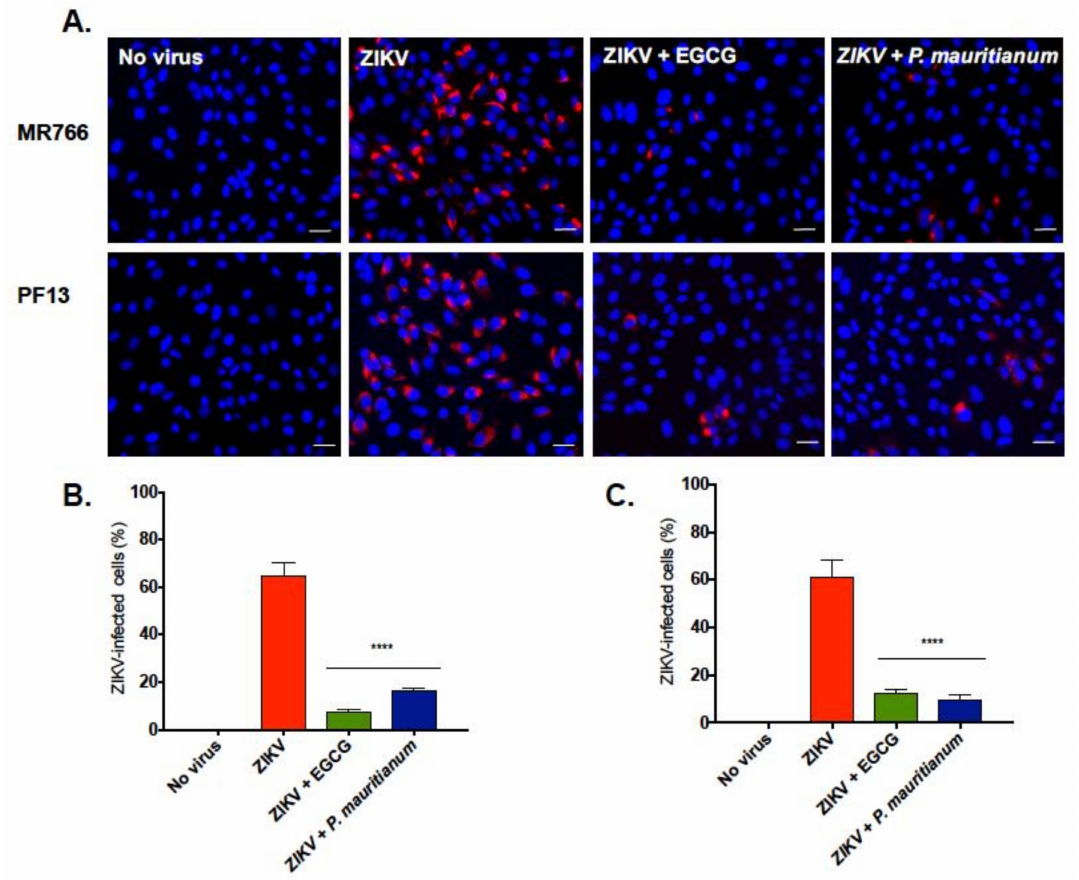
Figure 4. Antiviral activity of the P. mauritianum extract against the African and Asian ZIKV lineages. ZIKV-MR766 or ZIKV-PF13 were incubated with the P. mauritianum extract for 1 h at 37 ◦ C. EGCG (100 µ M) was used as a positive control. The Vero cells were infected at a MOI of 1 for 24 h. ( A ) The cells were processed for an immunofluorescence assay. The ZIKV E protein (red) and nuclei (blue) were visualized by fluorescence microscopy. The images are representatives of three independent experiments. Scale bars are 50 µ m. The quantification of the number of ( B ) ZIKV-MR766 and ( C ) ZIKV-PF13 infected Vero cells from the experiments are represented in the images. The results shown are the means ± SD of three independent experiments. Statistical analyses were performed using a one-way ANOVA and Dunnett’s test for multiple comparisons (**** p <